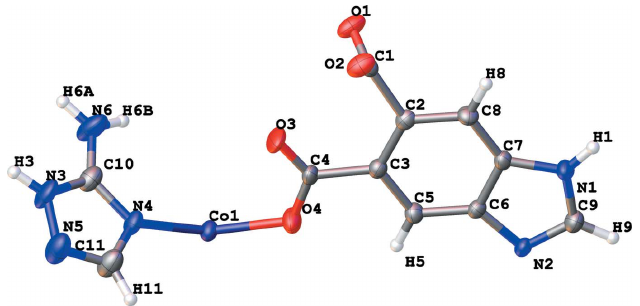
Figure 1 A view of the asymmetric unit of the title coordination polymer showing the atom numbering with displacement ellipsoids drawn at the 50% probability level.